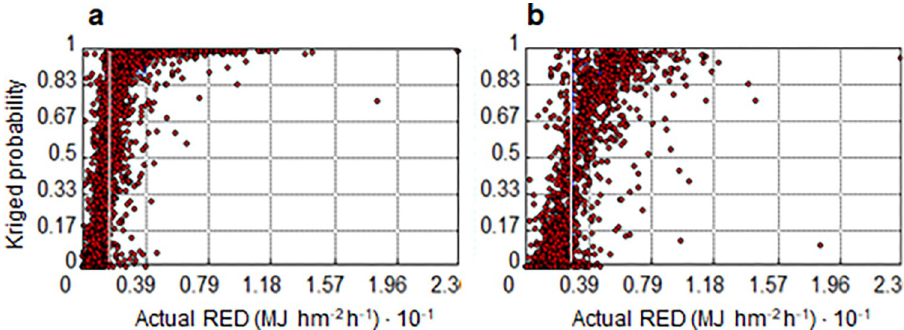
Fig 6. Cross-validation for warning and alert states. Scatterplots between actual rainfall erosivity density (RED) values above the given threshold and LNOKpm probability for the thresholds a) z (RED) > 3.0 MJ hm -2 h -1 . The white vertical lines in both graphs represent the respective RED thresholds (a, warning state; b, alert state). The cross-validation scatter diagrams ( a and b ) show that the actual RED values below and above the given thresholds at the warning and alert states are in agreement with the respective kriged